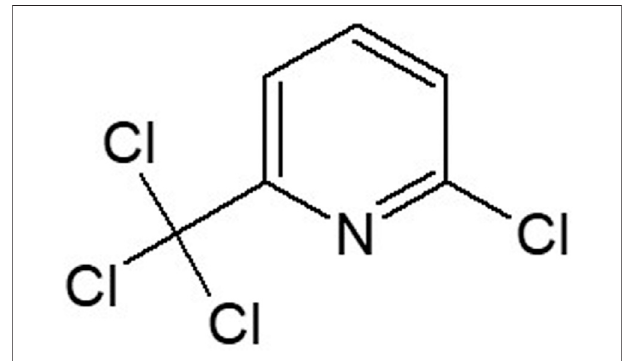
FIGURE 1 | Nitrapyrin chemical